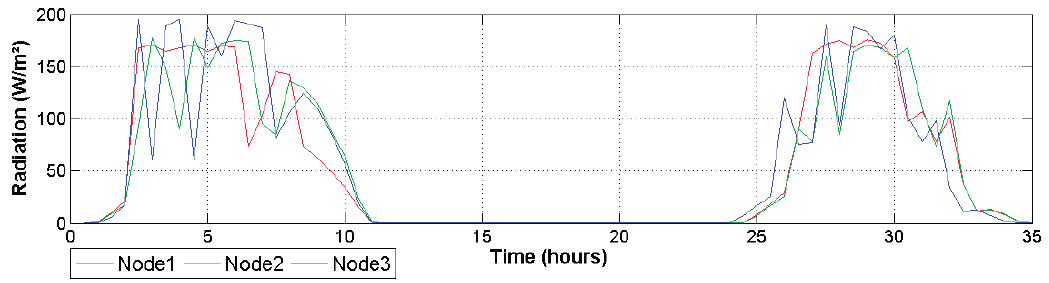
Figure 8. Image zooms for two days of